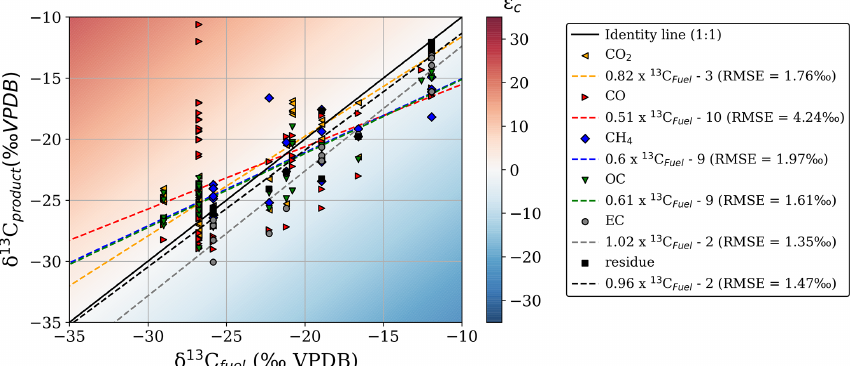
Figure 2. δ 13 C of the combustion products compared to the δ 13 C of the original fuel. The plot area colour scale represents the absolute fractionation ( ε ) compared to the precursor fuel. Linear regression formulas of the different curves and RMSE values are given in the legend on the